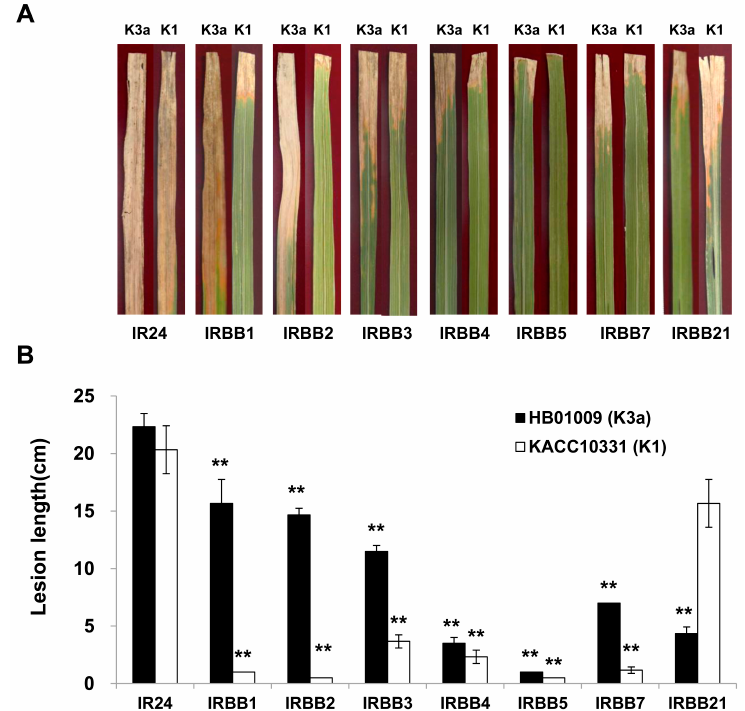
Figure 1. Virulence assay ( A ) and lesion length ( B ) of rice varieties inoculated with two Xanthomonas oryzae pv. oryzae strains (K1 and K3a race). Asterisks represent statistically significant differences relative to a susceptible rice cultivar (IR24) (paired, two-tailed Student’s t test, ** p -value < 0.01).